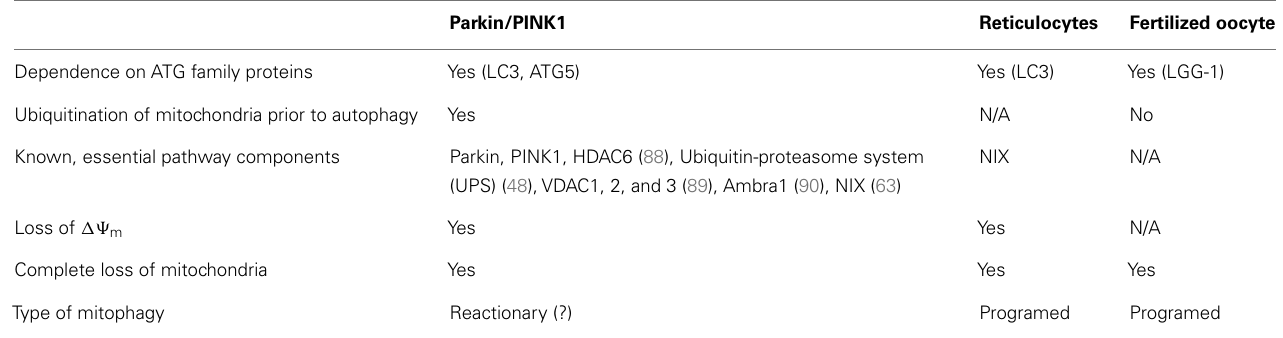
Table 1 | Comparison of mitophagy pathways. Parkin/PINK1 Reticulocytes Fertilized